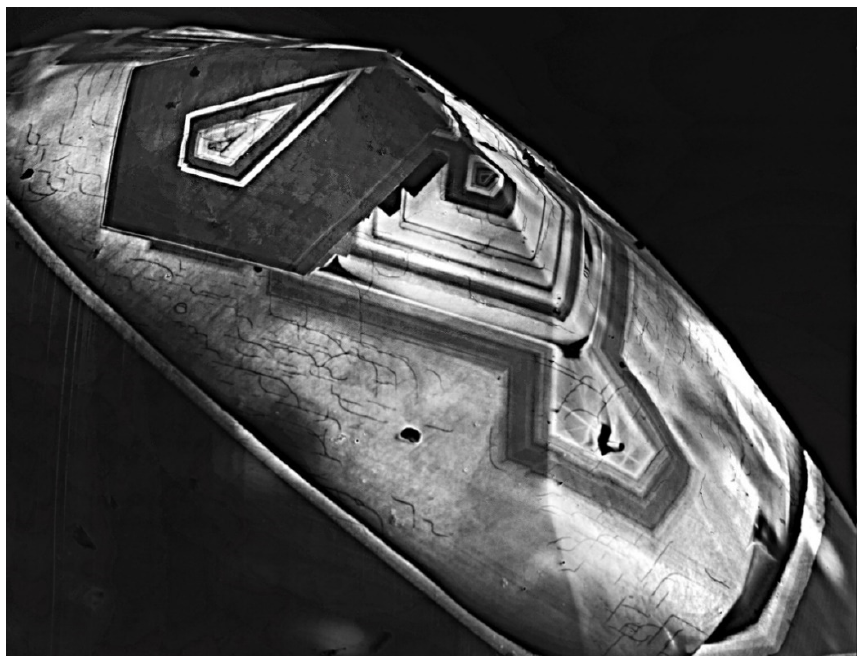
Figure 3 . Enlarged part of the surface of dissolved type Ib yellow cuboid diamond near L 3 axis. First steps of {111} regeneration stage are shown ‐ highly contrasting, straight “redoubt ‐ like” inhomogeneities, visualized only in CL. The scale bar is 0.2 mm.